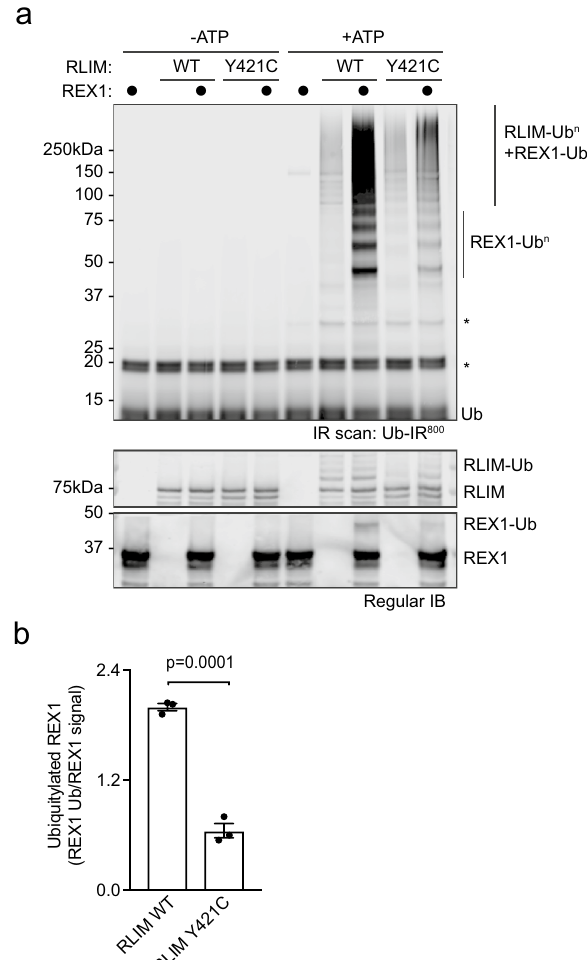
Figure 3. The p.(Tyr421Cys) variant impairs RLIM catalytic E3 ubiquitin ligase activity and substrate ubiquitylation. ( a ) Recombinant human RLIM wild-type (WT) or Y421C TOKAS variant were assayed for E3 ubiquitin ligase activity by incubating with UBE1 E1, UBE2D1 E2 conjugating enzyme in the presence or absence of ATP and recombinant REX1 substrate. REX1-specific substrate ubiquitylation (REX1-Ub n ) and RLIM, REX1 and/or free ubiquitin chains (RLIM -Ub n + REX1-Ub n ) are indicated. RLIM and REX1 protein levels were determined by immunoblotting, and ubiquitylated RLIM and REX1 indicated. Infrared images were generated by LI-COR Biosciences Image Studio v5.2 software (https:// www. licor. com/ bio/ image- studio/). ( b ) Quantification of E3 ubiquitin ligase activity of RLIM wild-type (WT) or Y421C TOKAS variant. Data are represented as mean ± standard error of the mean (n = 3). Statistical significance was determined by student’s t-test. Figure was generated using Graphpad Prism v8.0 (https:// www. graph pad. com/ scien tific- softw are/